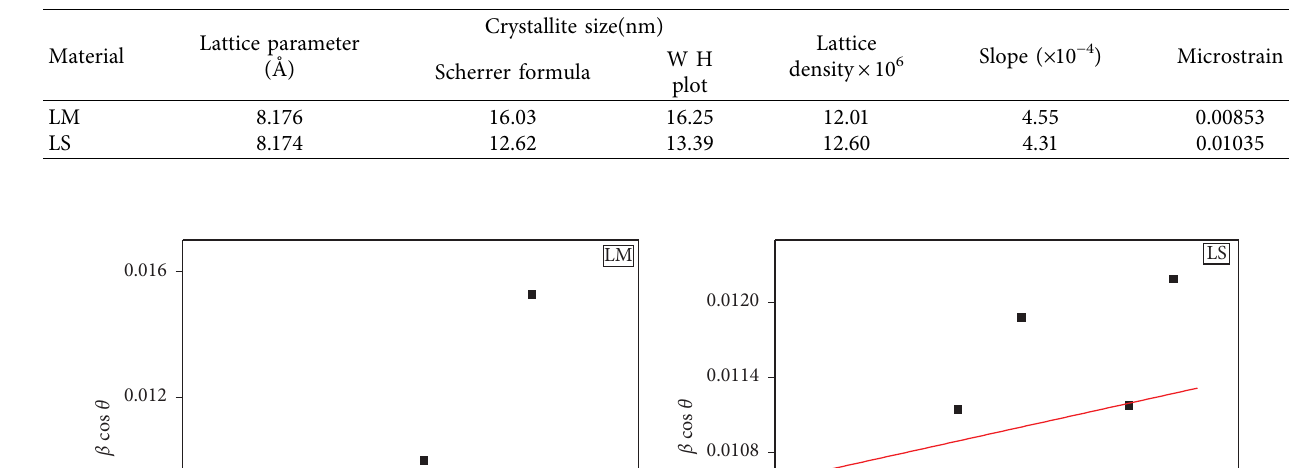
Table 1: XRD parameters of LM and LS.